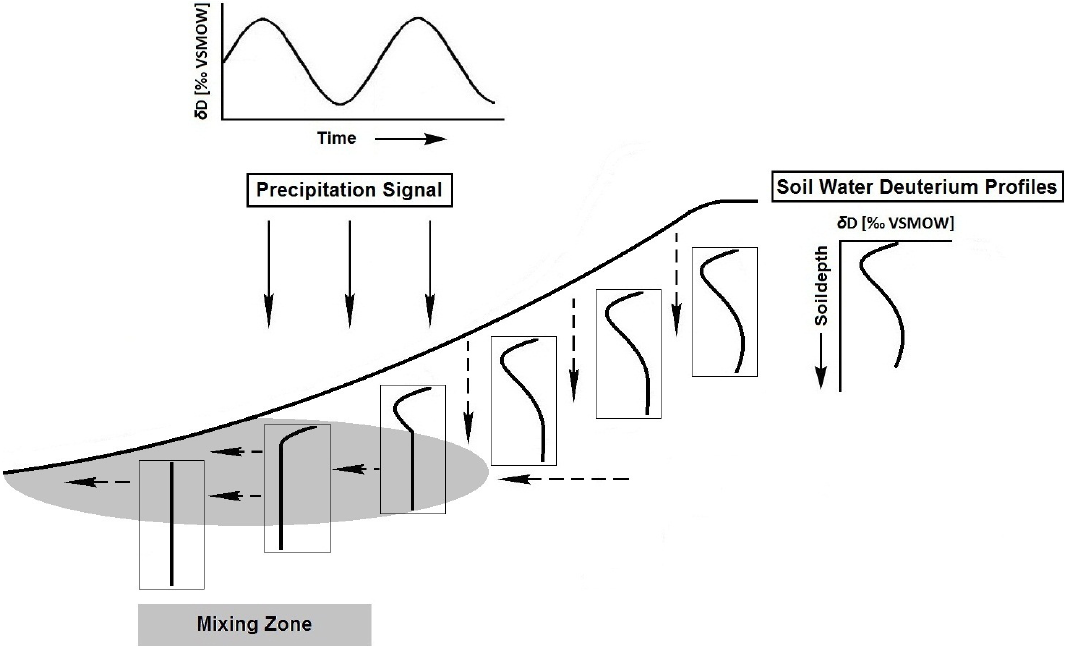
Fig. 10. Perceptual model of subsurface hydrological processes at the study